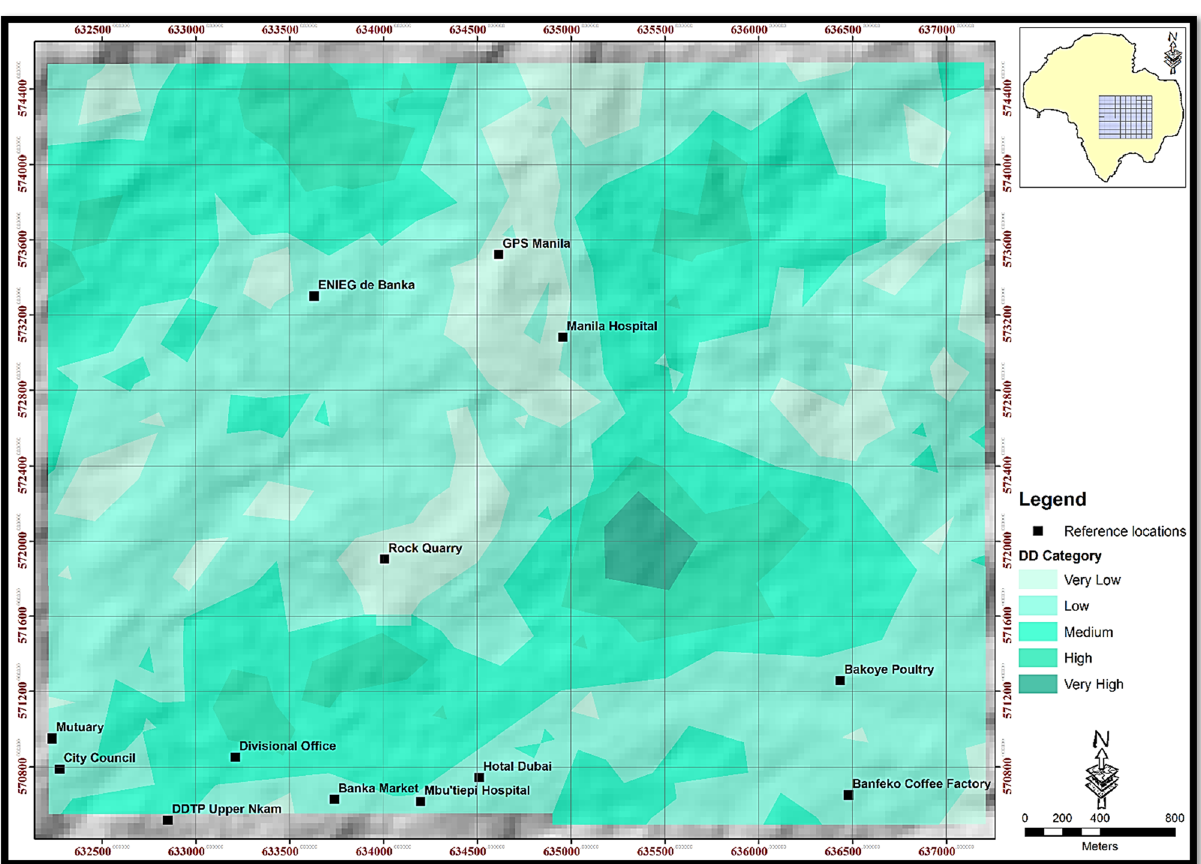
Fig. 10 Drainage density map of study